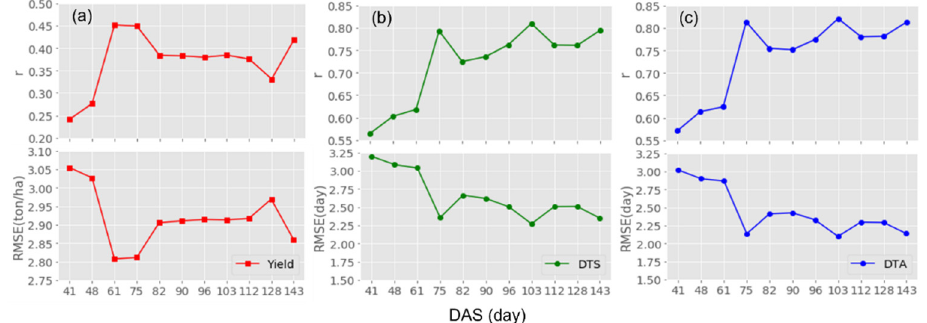
Figure 5. Line chart of the Pearson correlation coefficients ( r ) and RMSE between the observed and predicted ( a ) yield, ( b ) DTS, and ( c ) DTA using the full band spectral reflectance along the growing season.